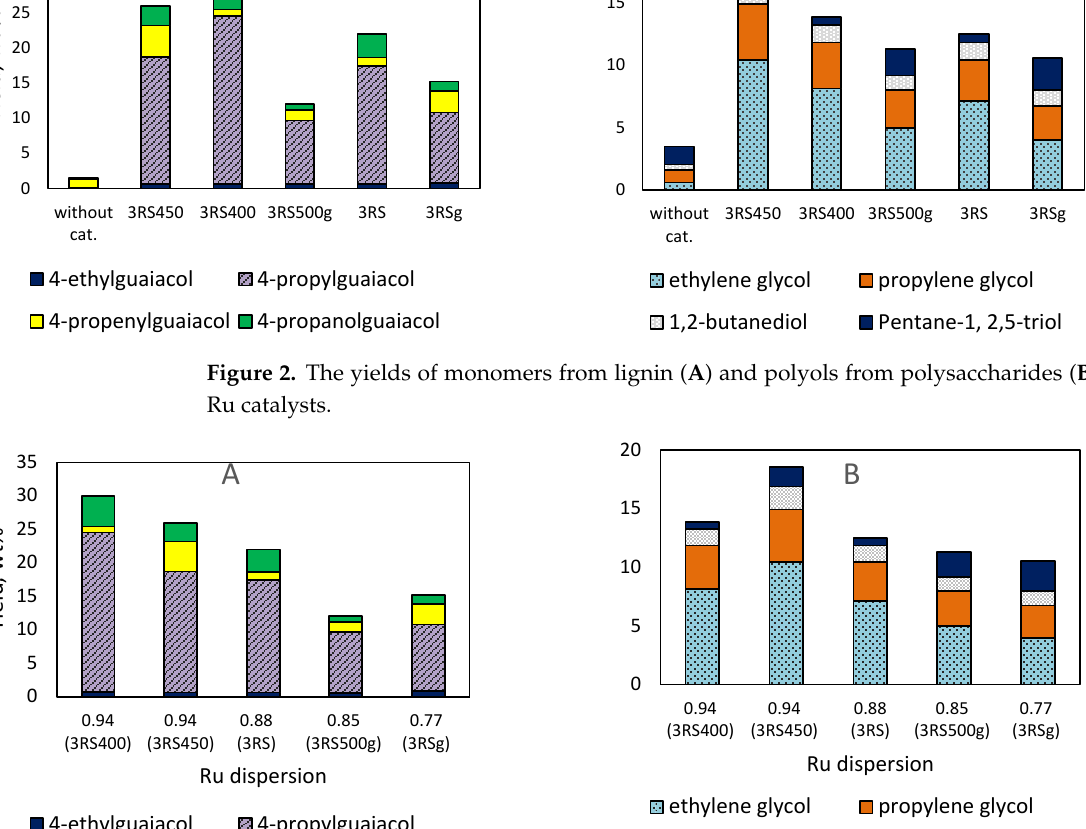
Figure 4. Van Krevelen diagram for the liquid products of spruce wood RCF at 225 ° С for 3 h over different catalyst ( a Original (non-oxidized) support; b the grain size is 1.0 – 1.6 mm). Carbon oxides (4.4 wt%) and trace methane (less than 0.1 wt%) were detected in gaseous products of non-catalytic hydrogenation. The methane content increases signif- icantly (up to 4.5 wt%) in the gaseous products over the ruthenium catalysts. Ruthenium is known to catalyze CO 2 conversion to methane. The usual reaction temperature range is from 200 to 450 °C depending on the catalyst, support and the reaction conditions. So, it is reasonable to assume such pathways in our case. However, the main pathway of me- thane formation is catalytic hydrocracking of aliphatic structural fragments of lignin [42]. We examined the effect of the ruthenium content in the catalyst on the yield and composition of the products of spruce wood RCF at 225 ° С (Tab le 3).